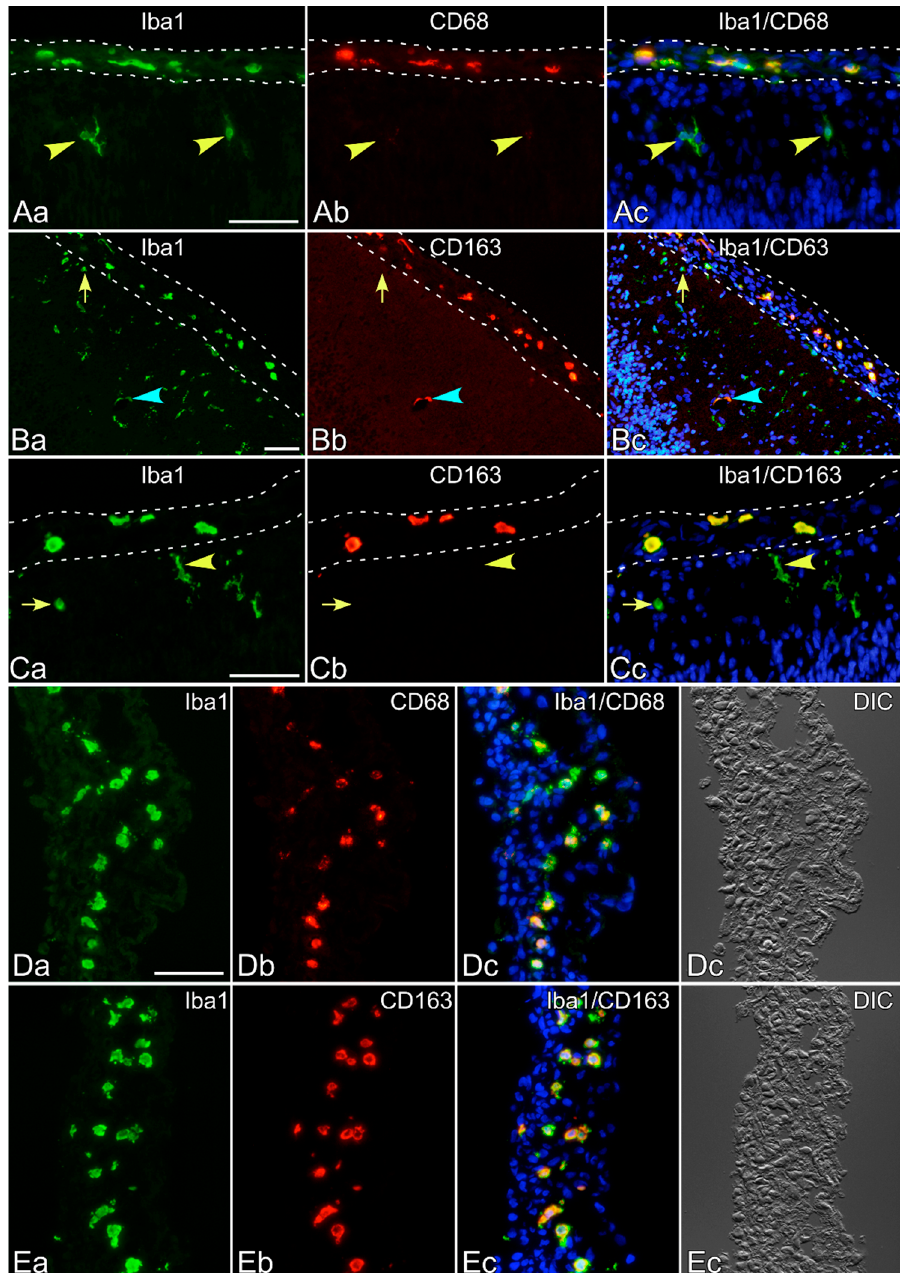
Figure 5. Expression of CD68 and CD163 in neonatal rat brains. ( A – C ) Sections of the neonatal rat cerebral cortex were immunostained with antibodies against Iba1, CD68, or CD163. Leptomeninges are surrounded by dotted lines. ( A ) Macrophages (green) in the leptomeninges strongly expressed CD68 (red), whereas ramified microglia in the brain parenchyma (green, denoted by yellow arrowheads) faintly expressed it. Nuclei were stained blue by Hoechst 33258. ( B , C ) Macrophages in the leptomeninges, but not ramified microglia in the brain parenchyma (a yellow arrowhead in ( C )), expressed CD163 (red). Even amoeboid microglia in the parenchyma (denoted by a yellow arrow in ( B , C )) were CD163 − . Pericytes around small vessels (green, denoted by a blue arrowhead in ( B )) expressed CD163 (red). Nuclei were stained blue by Hoechst 33258. ( D , E ) The peeled ‐ off leptomeninges contained amoeboid cells that expressed CD68 ( D ) and CD163 ( E ). Almost all macrophages (red) expressed both CD markers (red). Nuclei were stained blue by Hoechst 33258. Scale bar = 50 μ m.